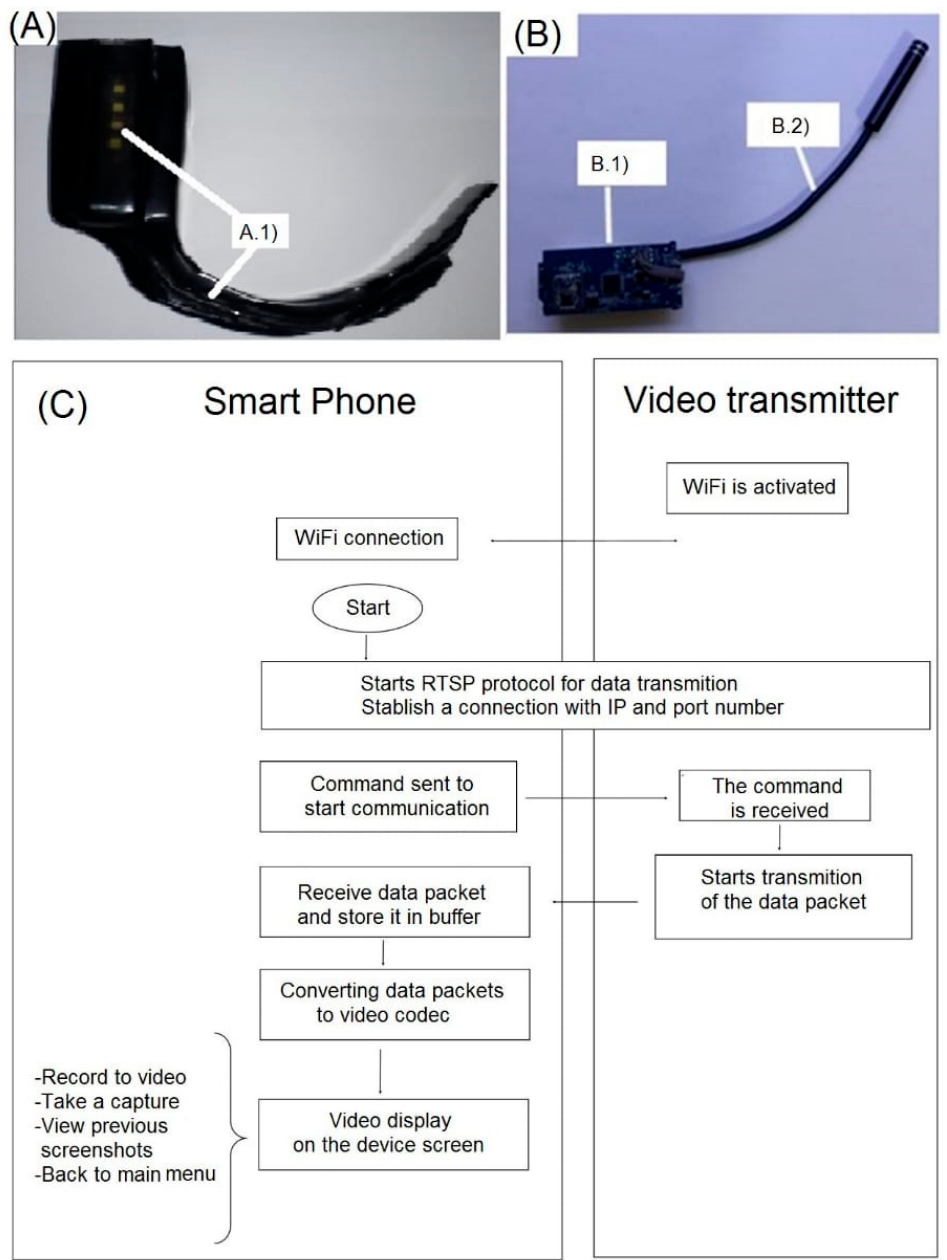
Figure 1. Main components of the developed Hybrid 1.0 video laryngoscope (VDL). ( A ) Shovel with parabolic geometry. ( B ) Wi-Fi video transmitter board. ( C ) Block diagram of the video transmission module and its wireless connection with a smartphone.